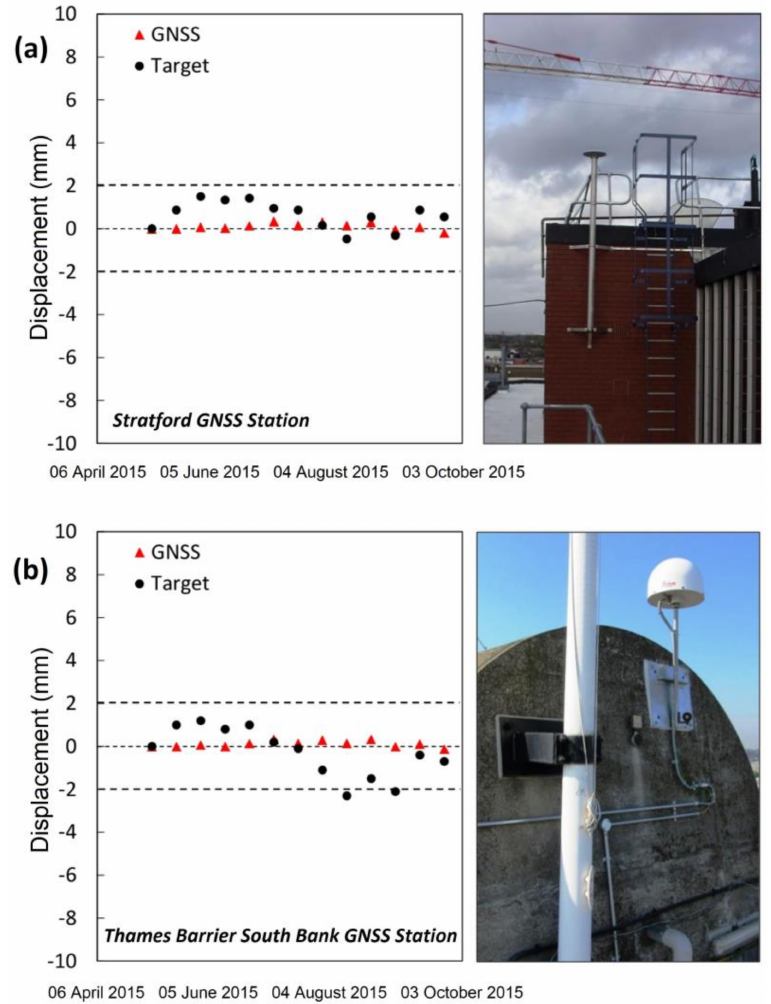
Figure 5. Comparison between the PSI and GNSS vertical displacement time series. See Figure 2 for the GNSS stations location. The antenna installation images are also reported (available data at